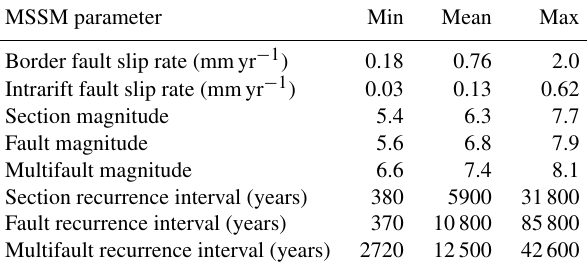
Table 3. Range and mean of selected attributes in the MSSM. The reported values are calculated by considering the intermediate esti- mates from all MSSM sources for the given type. The analysis of recurrence interval intermediates assumes that each source ruptures only in the given